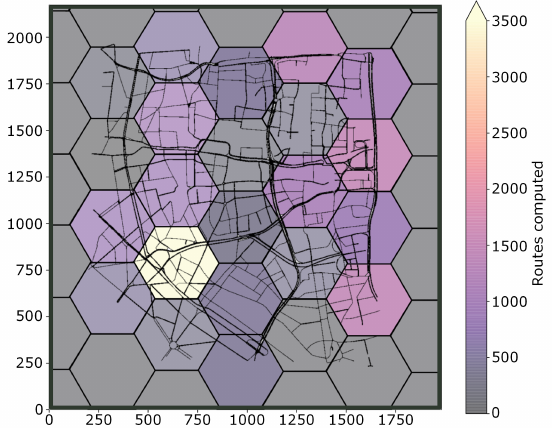
Figure 23. Routes computed per region—Cologne